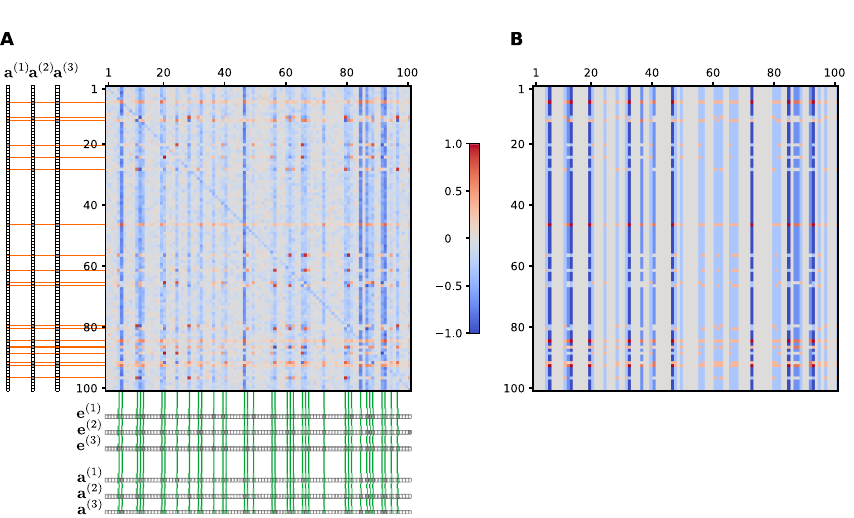
Fig 5. Structure of the interaction matrix obtained with the evolutionary algorithm as compared to the analytically derived one for three developmental pathways. (A) The evolutionary interaction matrix was obtained by averaging the output of 300 independent runs of the evolutionary algorithm. The three applied environment-specific embryonic and adult state vectors are shown along the sides. Orange guidelines highlight those rows where the corresponding genes are expressed in at least one adult state, whereas green guidelines highlight those columns where at least one gene is expressed in any of the embryonic or adult states. (B) The theoretically predicted interaction matrix was constructed from the embryonic and adult state vectors using Eq (3). Parameters as in Fig 2 and Q = 3, K = 100, μ W = 0.05, μ e = 0.1, σ =